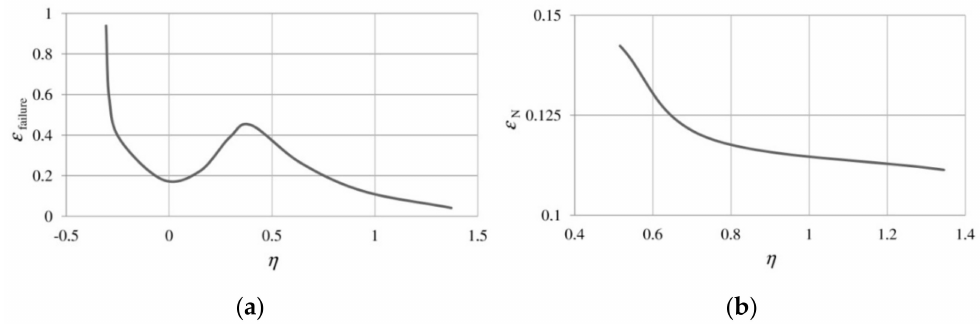
Figure 8. ( a ) Effect of stress triaxiality on strain at failure, from [7]; ( b ) dependence of the mean void nucleation strain on stress triaxiality